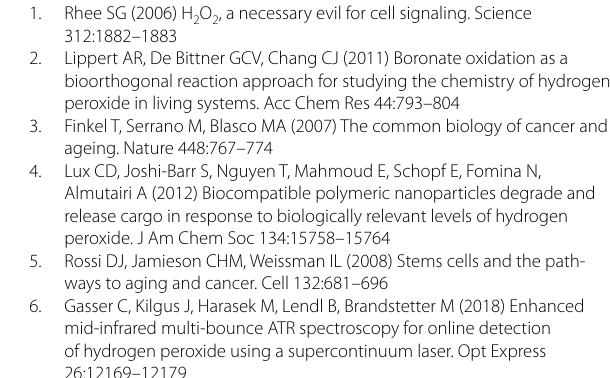
Fig. S3. EDX spectra of Co 2 P NPs. Fig. S4. Amperometric responses of Co 2 P/ITO electrodes prepared at (a) different temperatures and (c) dif- ferent times with successive addition of H 2 O 2 in 0.1 M PBS. (b), (d) The calibration curve of steady current versus the concentration of H 2 O 2 . Fig. S5. The linear relationship between current density and